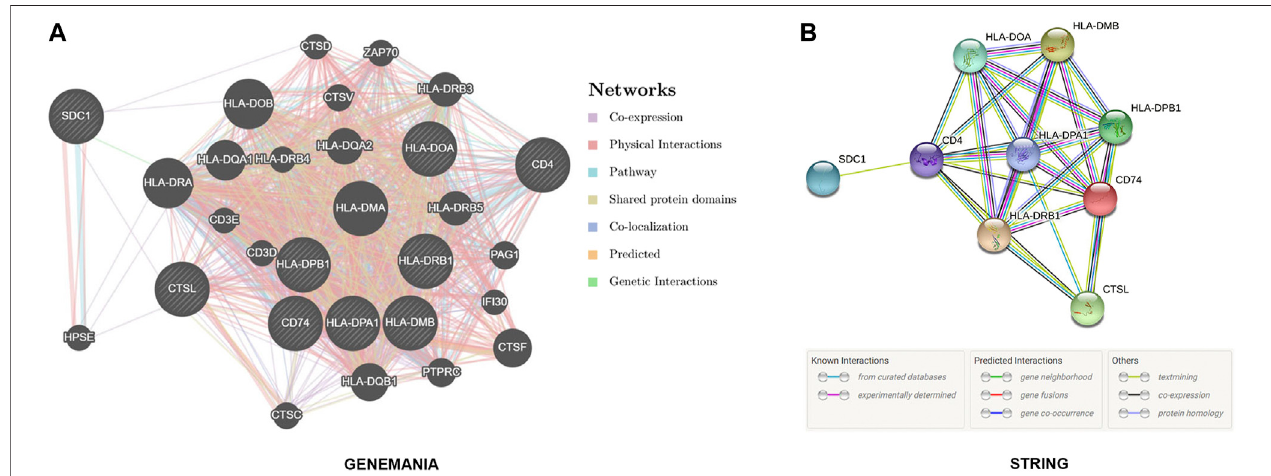
FIGURE 9 | GeneMANIA (https://genemania.org) and String ’ s online database (https://string-db.org) reveal that SDC1 may interact with CD4, CTSL, and HPSE directly or indirectly involved in the regulation of T cell